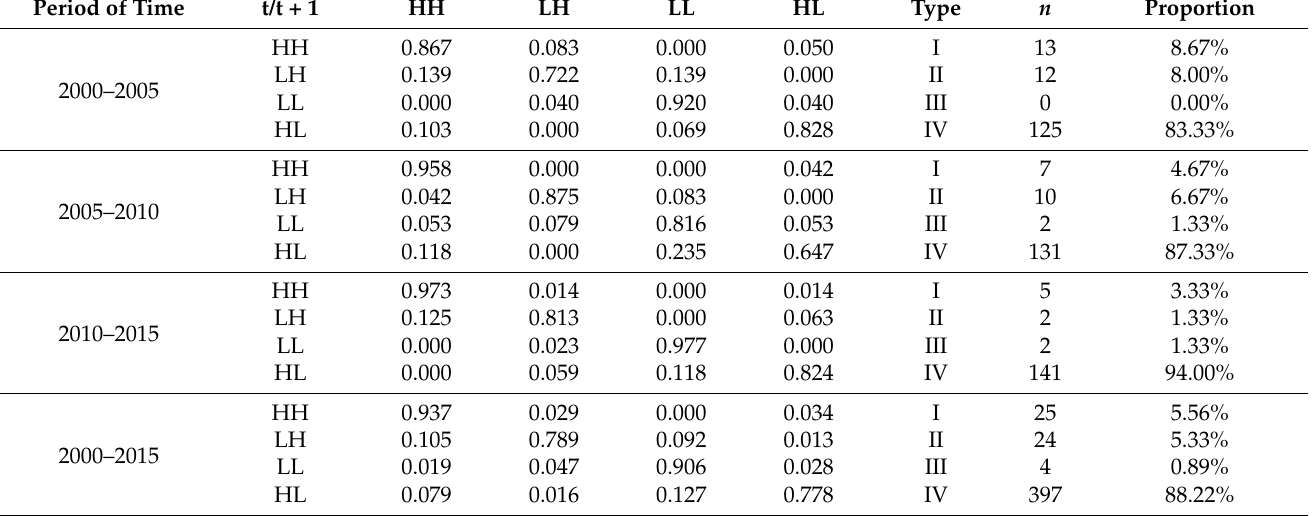
Table 3. Spatiotemporal transition matrices of rural energy